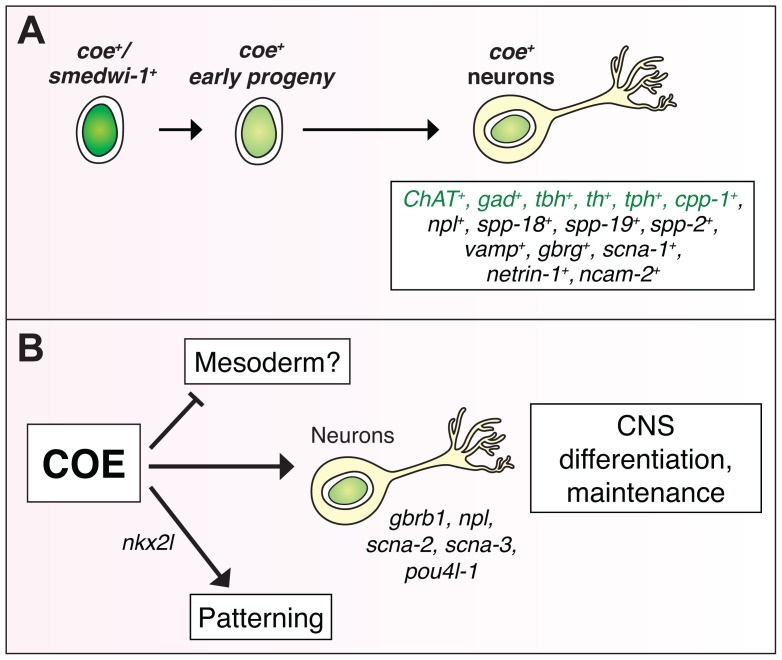
COE function is required for differentiation and maintenance of diverse neuron types.(A) coe is expressed in lineage-committed neoblasts (smedwi+) and early progeny [24], and diverse neuron types, including cholinergic (ChAT), GABAergic (gad), octopaminergic (tbh), dopaminergic (th), serotonergic (tph), and neuropeptidergic (cpp-1, npl, spp-18, spp-19, spp-2) neurons. Genes in green were identified in [24]. (B) To gain insights into how loss of COE function contributes to defects in nervous system differentiation, we analyzed the function of genes that were downregulated in coe(RNAi) animals. These analyses identified additional genes required for CNS regeneration (gbrb1, npl, scna-2, scna-3, pou4l-1) and patterning (nkx2l). In coe(RNAi) animals, we also detected upregulated genes enriched for GO terms associated with muscle development (Table 1), suggesting that COE may also function to repress the expression of mesoderm-specific genes.